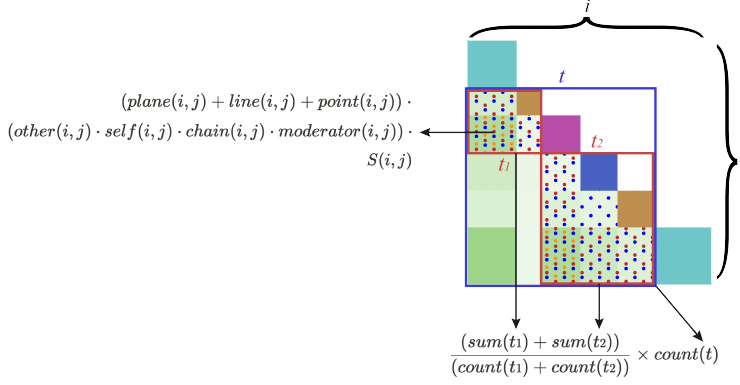
Figure 16. Graphical model representation of